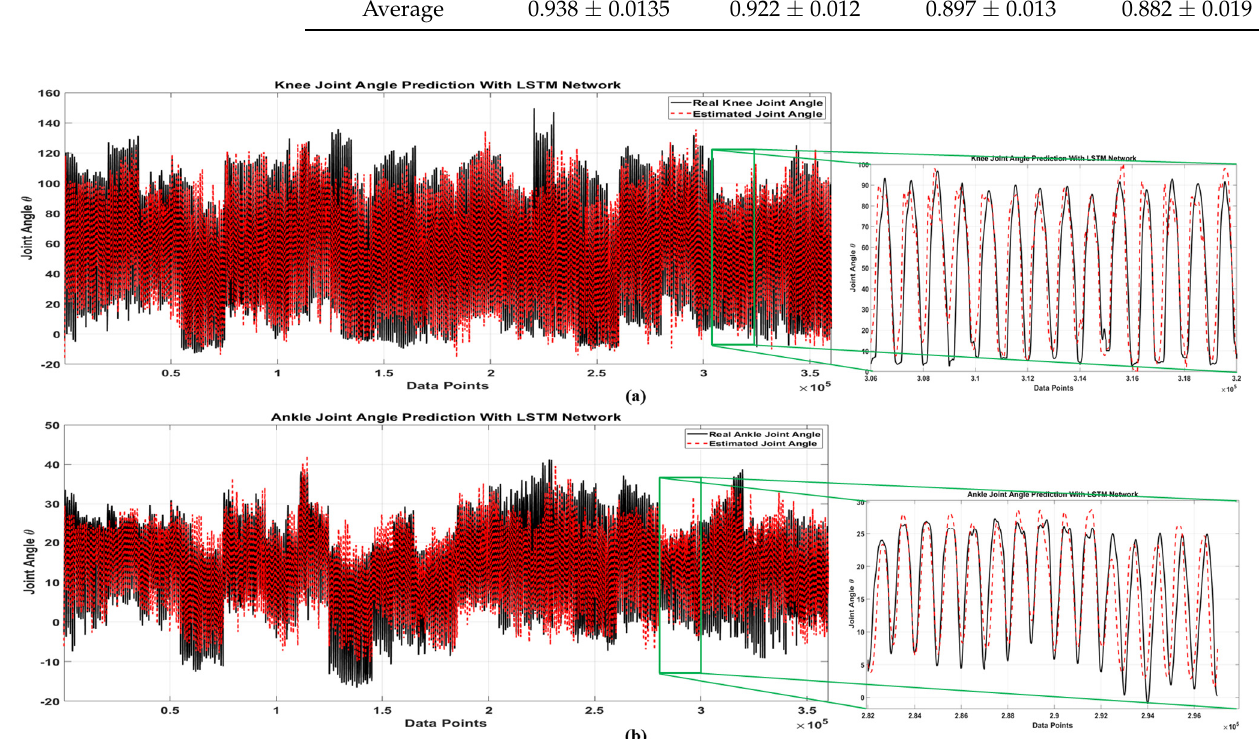
Figure 7. Full Data Prediction with LSTM Network; ( a ) Knee Joint ( b ) Ankle Joint. Table 1. Root mean squared error (RMSE) results for both model in two joints .